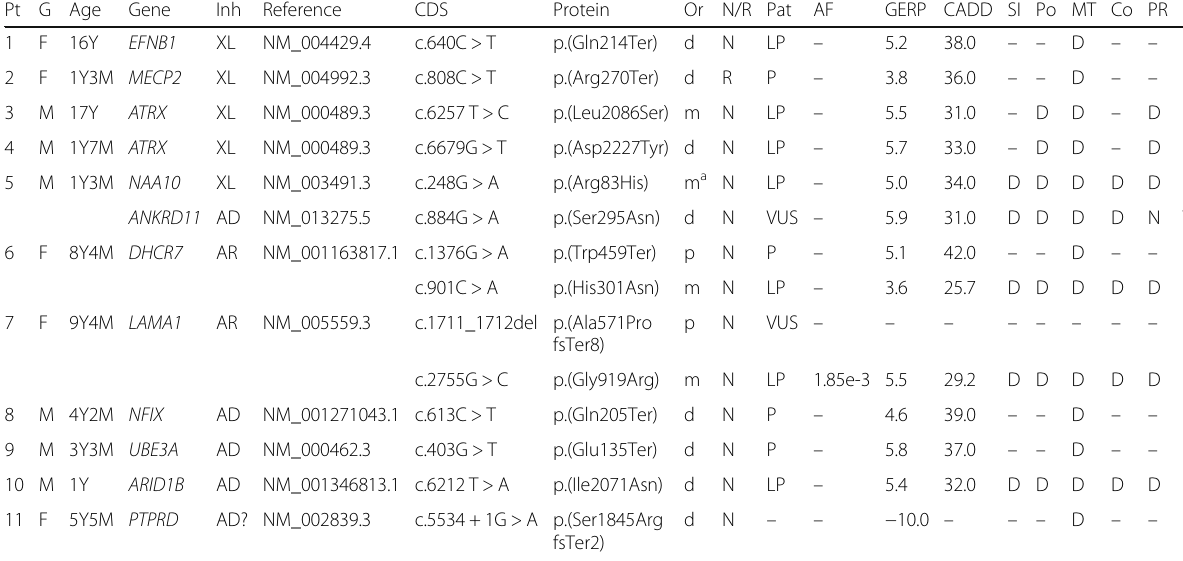
Table 2 Characteristics of 14 variants identified in 11 patients with intellectual disability/developmental delay Pt G Age